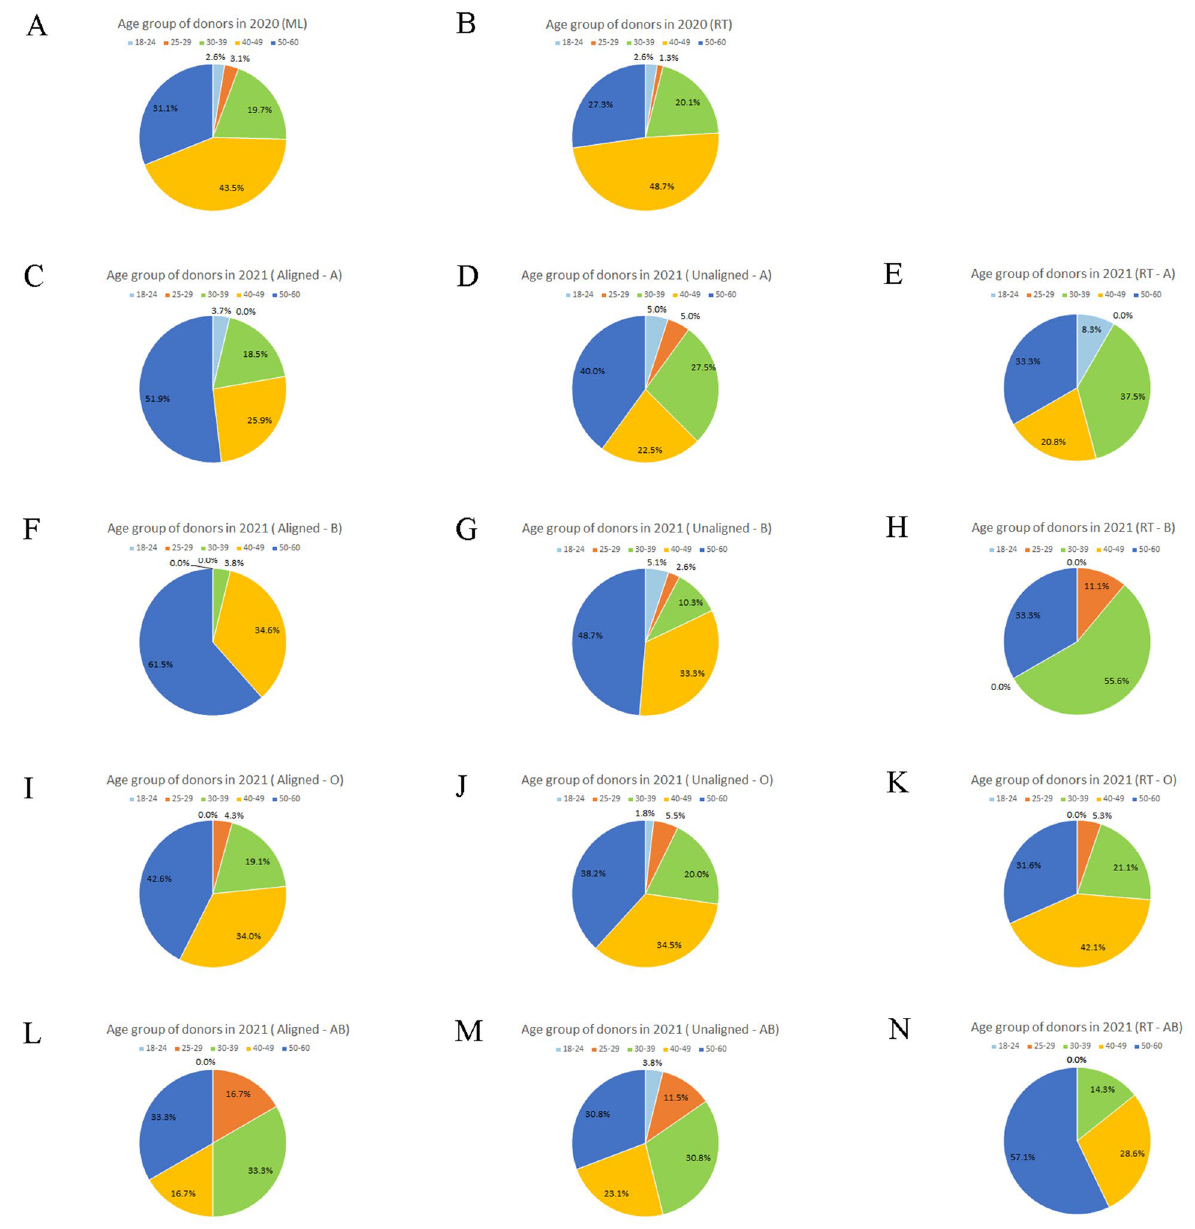
Figure 6. Statistics of donor’s age (years) in pandemic recruitment. The age characteristics of blood donors recruited were analyzed, donors with more than 40 years old made up the majority of donors successfully recruited during the pandemics. ( A ) Ages of donors in 2020 (ML). ( B ) Ages of donors in 2020 (RT). ( C ) Ages of donors in 2021 (Aligned-A). ( D ) Ages of donors in 2021 (Unaligned-A). ( E ) Ages of donors in 2021 (RT-A). ( F ) Ages of donors in 2021 (Aligned-B). ( G ) Ages of donors in 2021 (Unaligned-B). ( H ) Ages of donors in 2021 (RT-B). ( I ) Ages of donors in 2021 (Aligned-O). ( J ) Ages of donors in 2021 (Unaligned-O). ( K ) Ages of donors in 2021 (RT-O). ( L ) Ages of donors in 2021 (Aligned-AB). ( M ) Ages of donors in 2021 (Unaligned-AB). ( N ) Ages of donors in 2021